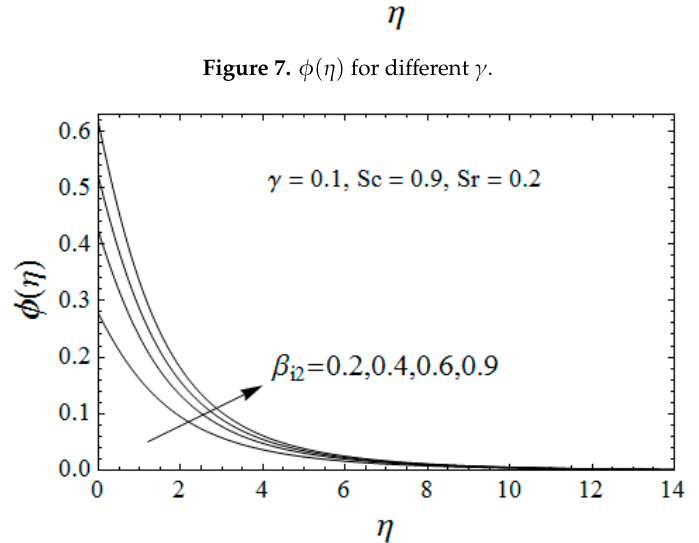
Figure 8. 𝜙(𝜂) for different 𝛽 (cid:3036)(cid:2870) . Figure 8. φ ( η ) for di ff erent β i 2